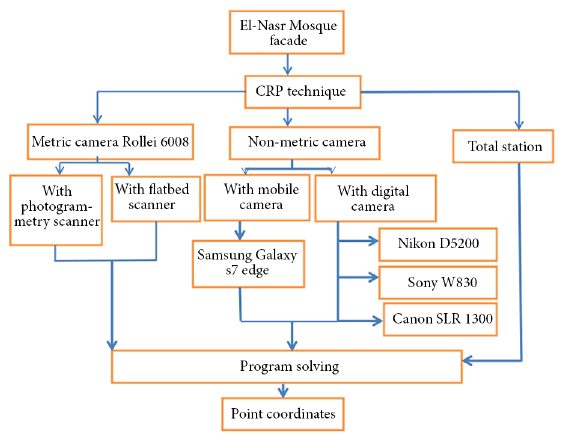
Figure 4. Steps and procedure of research work (field work and data analysis)